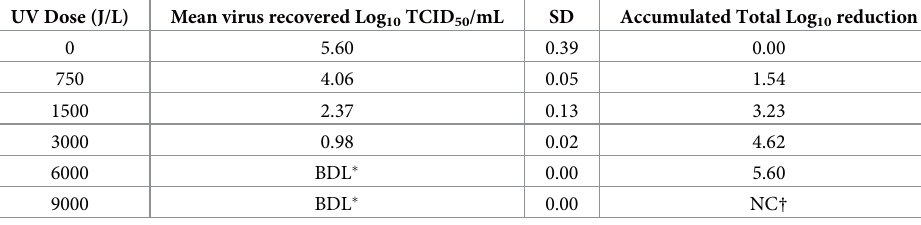
Table 2. Titration of ASFV samples subjected to different doses of UV-C irradiation.